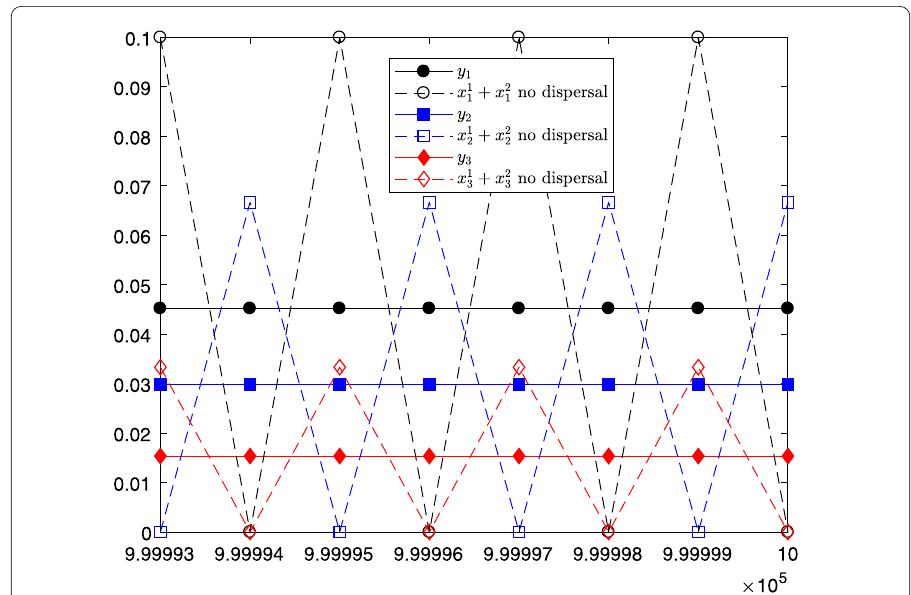
Figure 3 Changing local reproductive synchrony into global reproductive asynchrony when going from the local level (isolated identical patches with dynamics defined by matrices (28)) to the global level (represented by system (29)) when we incorporate dispersal. Parameter values: s 1 = s 2 = s 3 = 0.5, c = 1, d = 10, φ = 3.1, v 1 1 = 0.3, v 1 2 = 7/8, v 1 3 = 1/8. Initial conditions are X (0) = (0.02,0.02,0.05,0.05,0.02,0.02). The simulations have been run until time t = 10 6 and only the last 8 times are